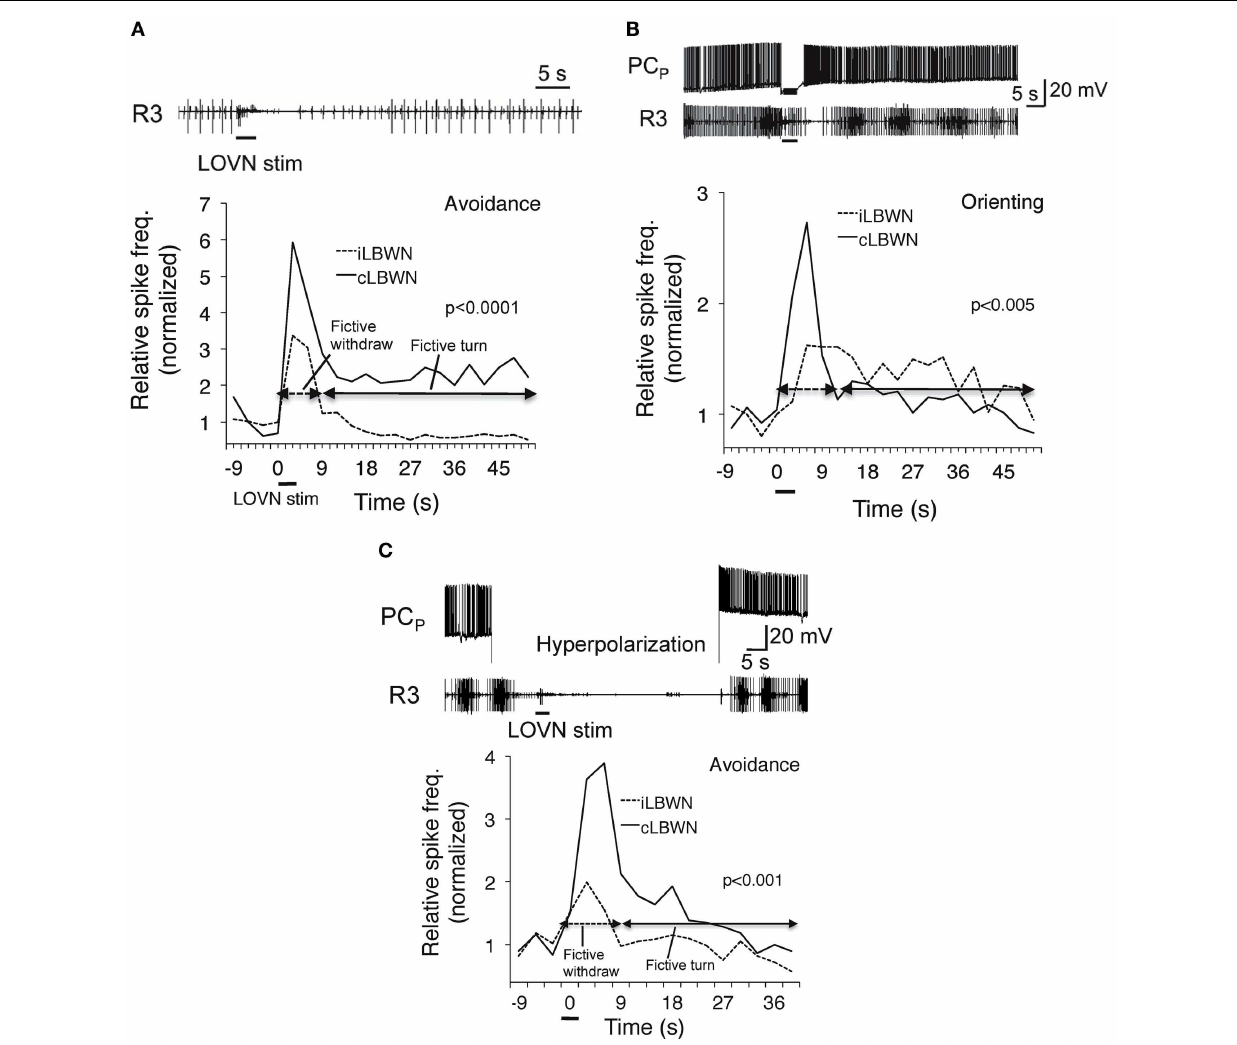
FIGURE 5 | Dependence of approach/avoidance decision on the excitation state of the feeding motor network. Fictive avoidance (A) was switched to orienting (B) following penetration of a feeding command neuron